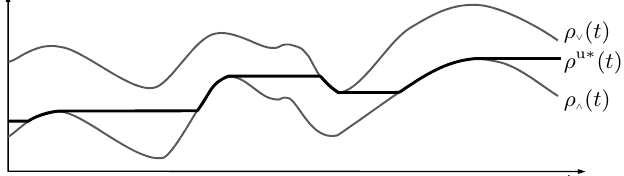
Fig. 1: Example of optimal density ρ u ∗ ( t ) , shown in black line, against the ( t ) and ρ ( t ) , shown in gray bounds ρ ∧ ∨